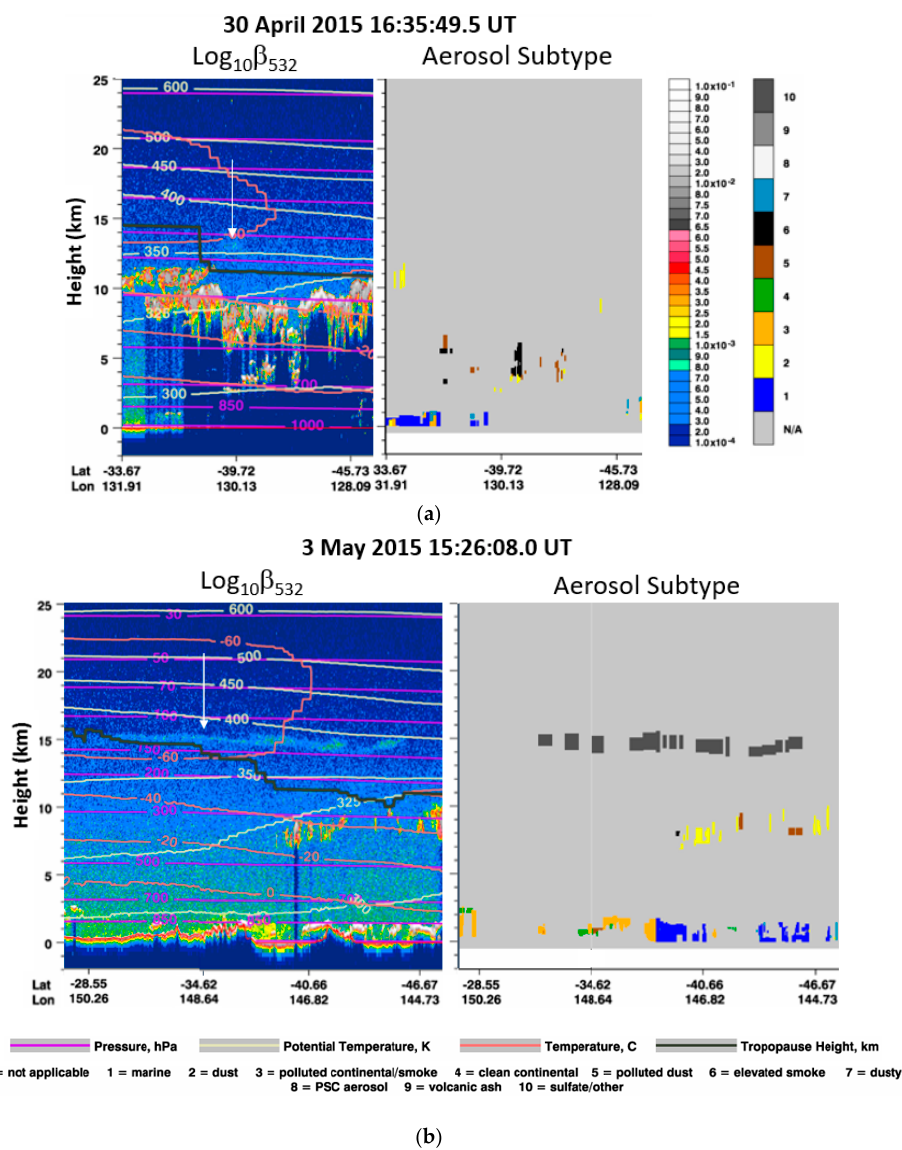
Figure 2. Selected Cloud-Aerosol Lidar with Orthogonal Polarization (CALIOP) analysis from version 4.10 browse images for ( a ) 30 April and ( b ) 3 May 2015. Shown for each date are height-time displays of unattenuated backscatter at left and analysed aerosol subtype at right. The color scales for backscatter and aerosol subtype are shown at right of panel ( a ). The legends for the contours in the backscatter panels and the filled regions in the aerosol subtype panels are shown at the bottom. The time in the heading indicates the starting time of each measurement curtain. The vertical white arrows highlight regions of enhanced stratospheric backscatter discussed in Section 3.1.